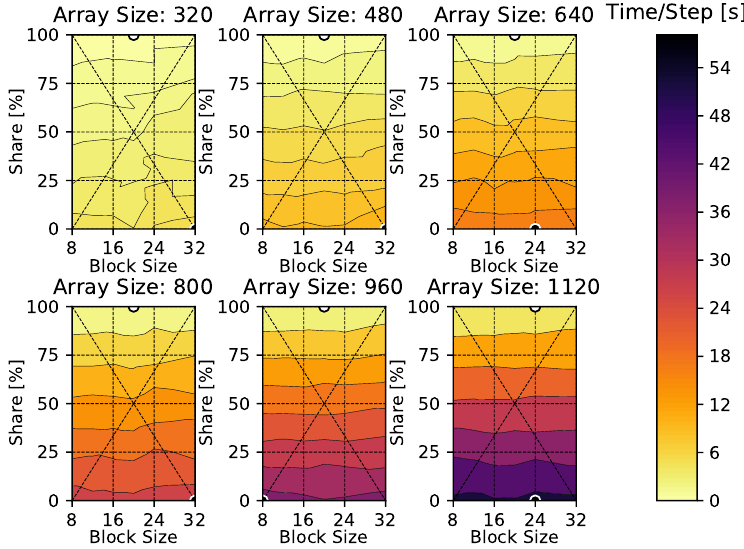
Figure A6. Euler equations time per timestep performance using Standard to solve the Euler equations with Intel E5-2698v4 CPUs and Tesla V100-DGXS-32GB